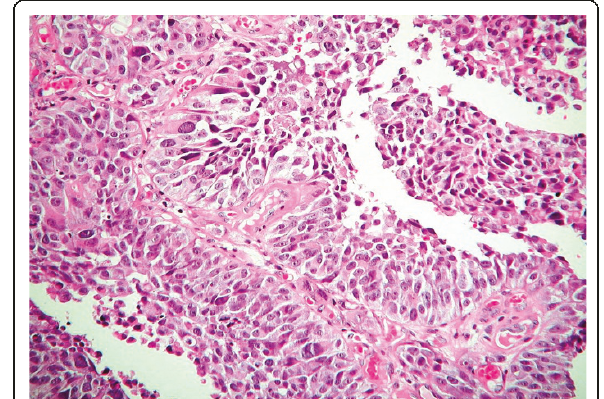
Figure 8 Low-grade papillary urothelial carcinoma . Figure 9 High-grade papillary urothelial carcinoma